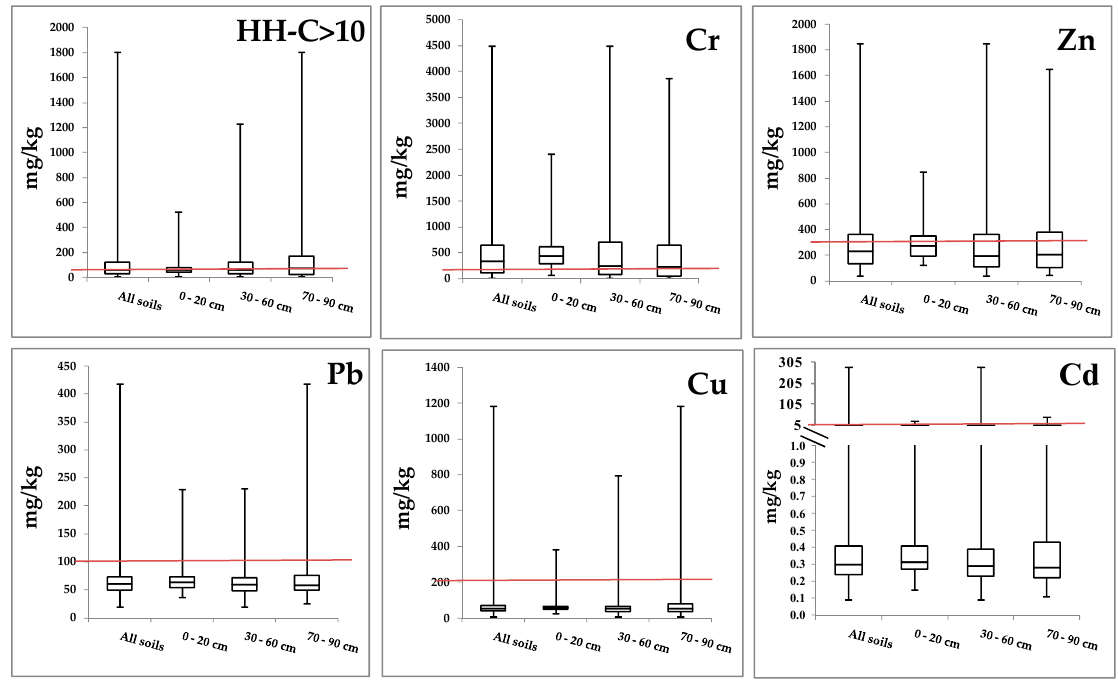
Figure 1. Total contents of HH-C > 10, Cr, Zn, Pb, Cu, and Cd (aqua regia digestion) in the soil samples ( n = 507) collected in the study site. Each plot represents the minimum and maximum (whiskers) and median (bar) values; the box ranges from the 25° to 75° percentile. Red lines indicate the Italian contamination threshold concentration for agricultural soil set by D.M. 46/2019.